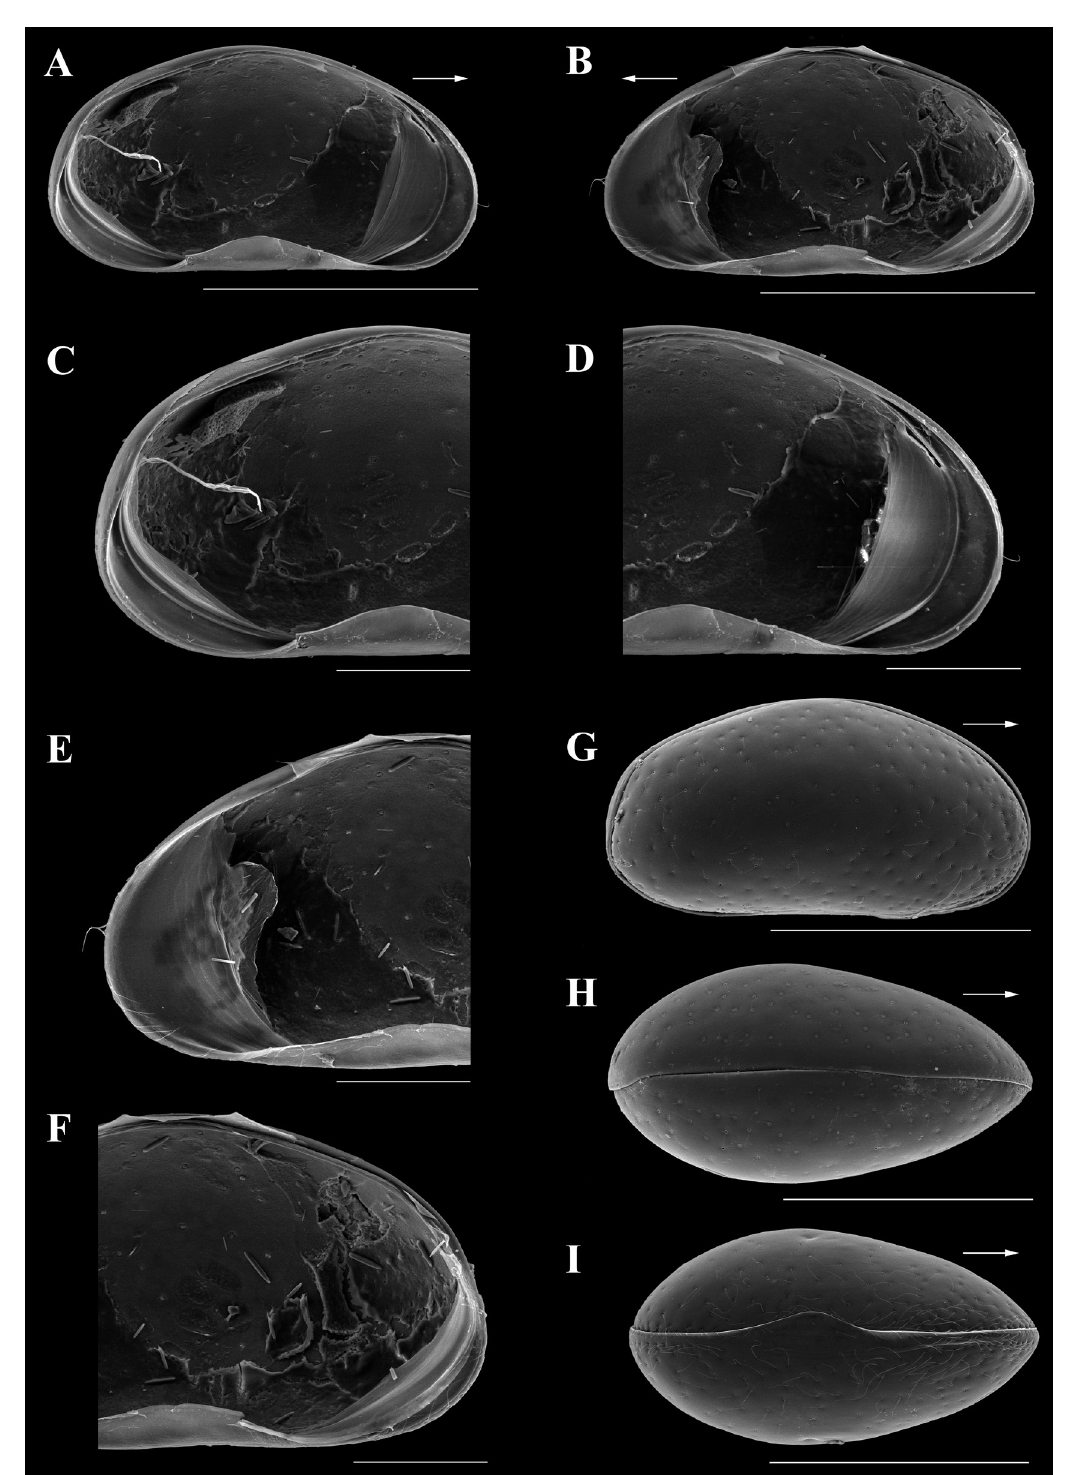
Fig. 16. Brasilodopsis amazonica gen. et sp. nov. from Amazon River floodplain, ♀. A . LVi (MZUSP 41862). B . RVi (MZUSP 41862). C . LVi, detail of posterior part (MZUSP 41862). D . LVi, detail of anterior part (MZUSP 41862). E . RVi, detail of anterior part (MZUSP 41862). F . RVi, detail of posterior part (MZUSP 41862). G . CpRl (MZUSP 41863). H . CpD (MZUSP 41864). I . CpV (MZUSP 41865). Scale bars: A–B, G–I = 300 µm; C–F =